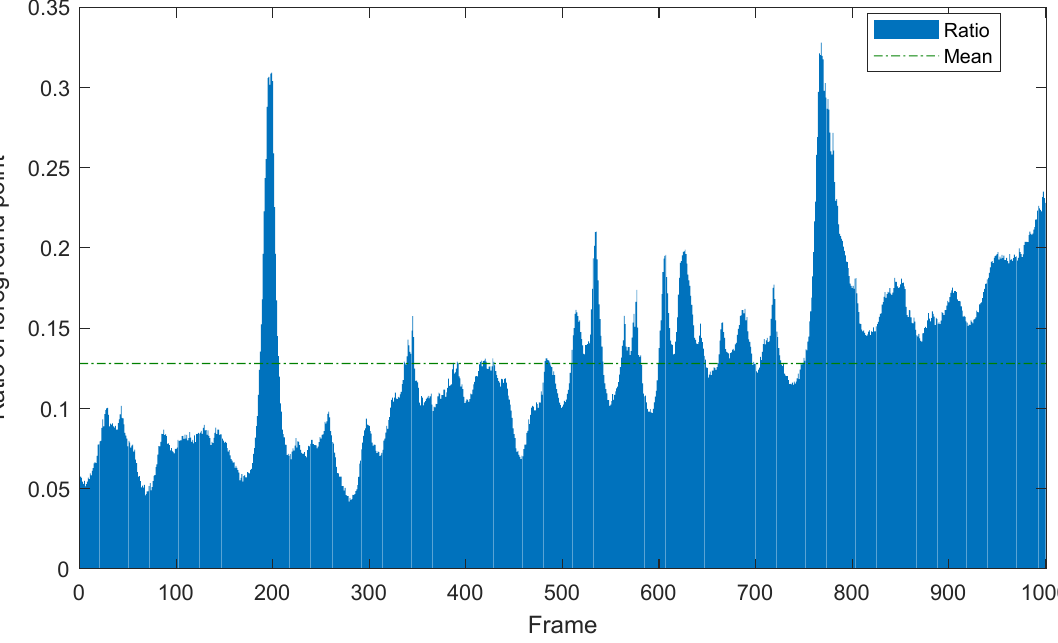
Figure 5. The ratio of the total number of foreground point clouds in 1000 frames. According to the characteristics of rotating LiDAR, the polar background grid is established with the azimuth and vertical angle so that the points in each frame can be placed in the azimuth and vertical-angle grid. The polar background grid ( R t ) is: